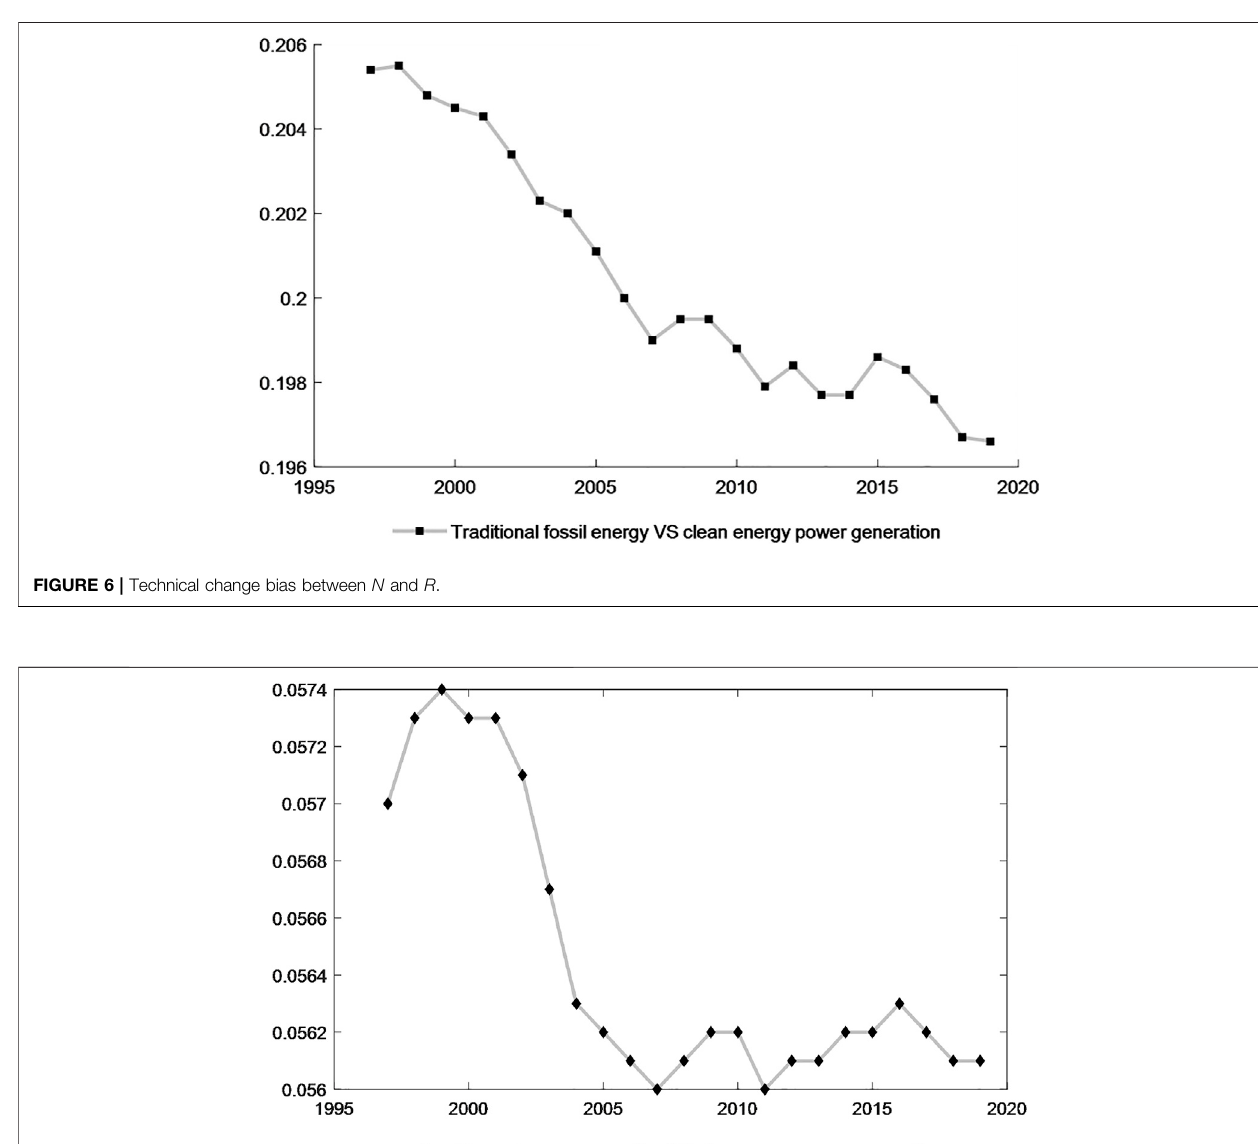
FIGURE 7 | Technical change bias between F and R